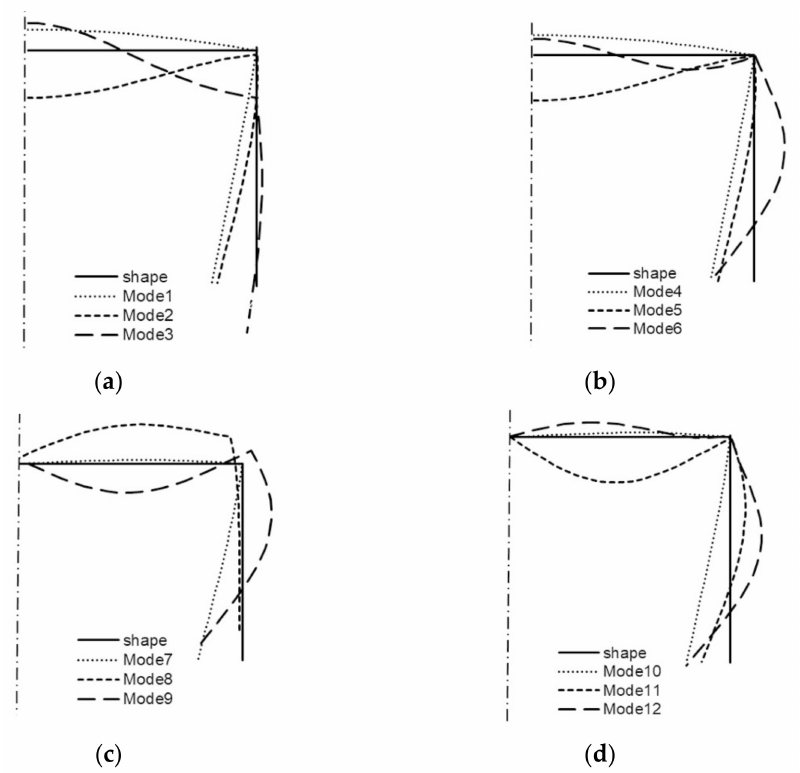
Figure 7. Buckling modes of the channel of the total length L = 250 mm (Table 1): symmetrical modes 1, 2, 3 ( a ), modes 4, 5, 6 ( b ), and anti-symmetrical modes 7, 8, 9 ( c ), modes 10, 11, 12 ( d